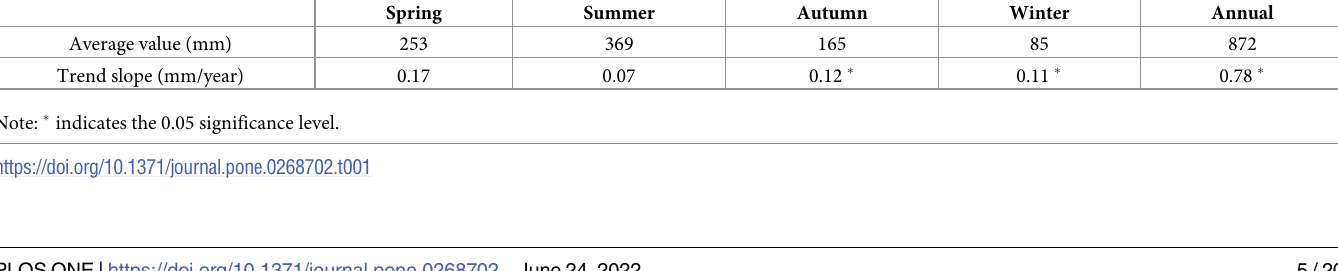
Table 1. Analysis of seasonal and annual PET throughout the entire SC-CQ region from 1970 to 2020 using the Mann-Kendall test.